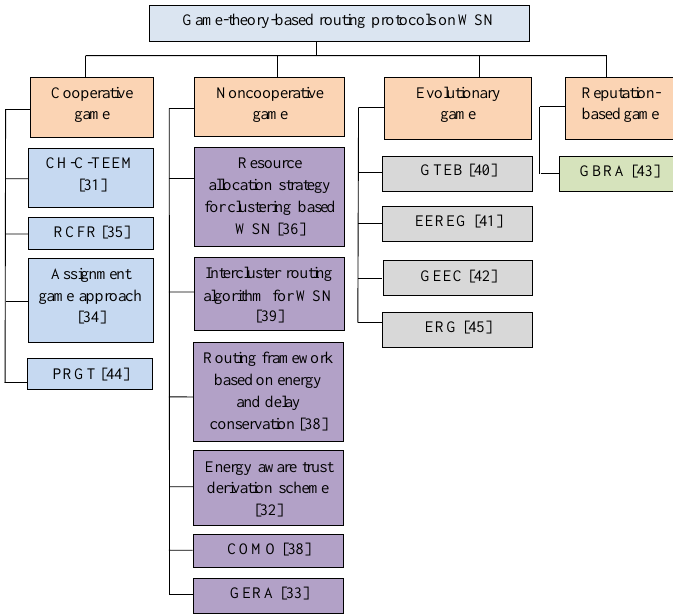
Figure 1. Categories of game theory-based routing protocols for wireless WMSNs: CH-C-TEEM: Cluster Head Cooperative Trustworthy Energy-Efficient multiinput multioutput; RCFR: Reliable Coalition Formation Routing; PRGT: Probabilistic Routing Based on Game Theory; COMO: Cooperation Optimal Protocol for Multirate Opportunistic Routing; GERA: Game-Theory-Based Energy-Efficient Routing Algorithm; GTEB: Game Theoretic Energy Balanced Routing; EEREG: Energy-E ffi cient Routing Protocol based on Evolutionary Game; GEEC: Game-Theory-Based Energy-E ffi cient Clustering; ERG: Evolutionary Routing Game; GBRA: Game-Theory-Based Routing